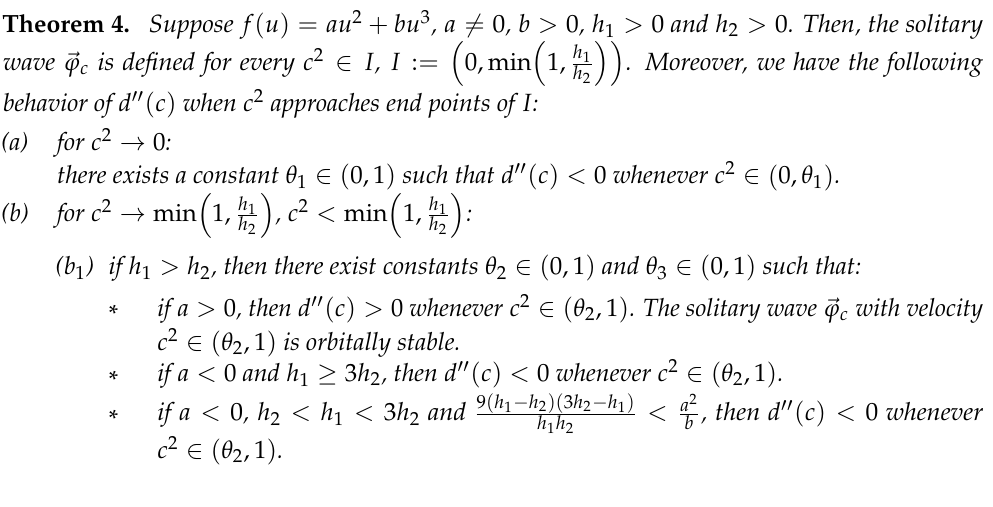
Figure 4. The region of orbital stability ( d (cid:48)(cid:48) > 0) for h 1 / h 2 = 0.5, a | a | left half-plane is for a < 0; right half-plane is for a >